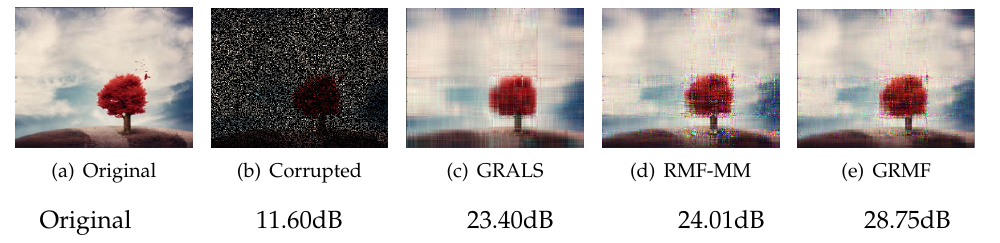
Figure 4. The PNSRs of Image recovery with Gaussian noise.